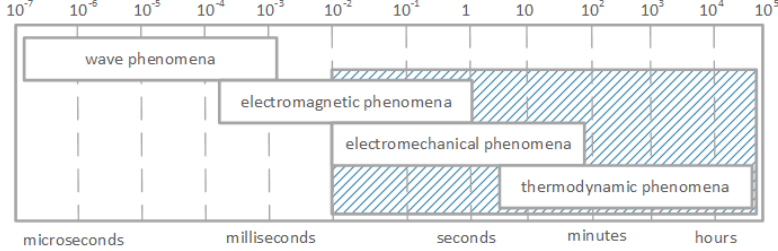
Figure 1. The time frames of the basic power system dynamics phenomena together with corresponding WSN monitoring capabilities.